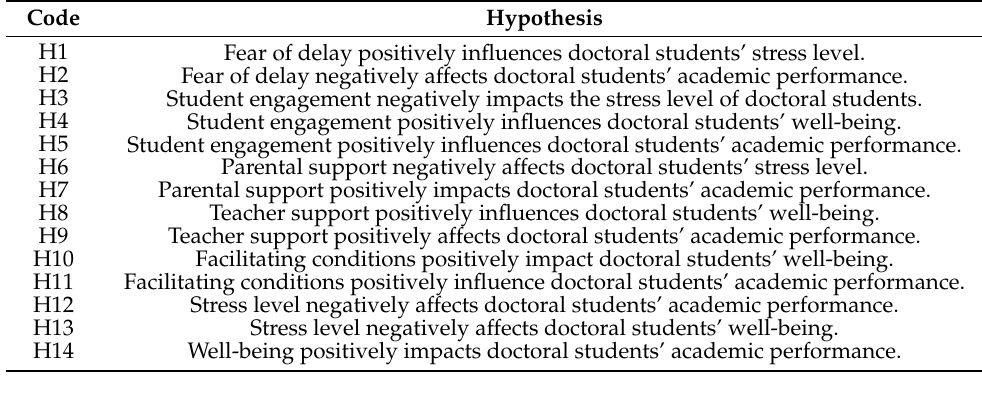
Table 1. Hypotheses in this study.